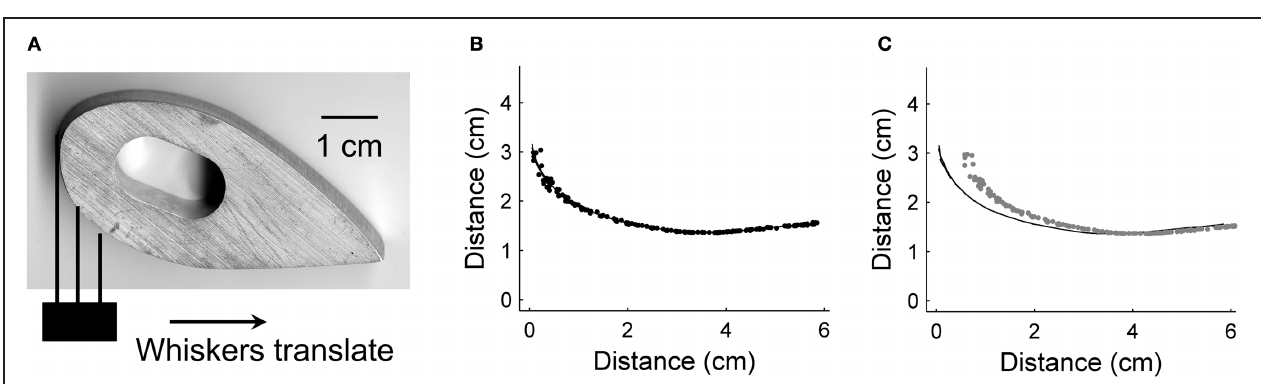
quantified exactly. (B) Predicted contact points mapped onto the test object. At the transition between curvatures, the absolute percent error of the prediction increases substantially. (C) Absolute percent error of the prediction for each of the predicted data points.